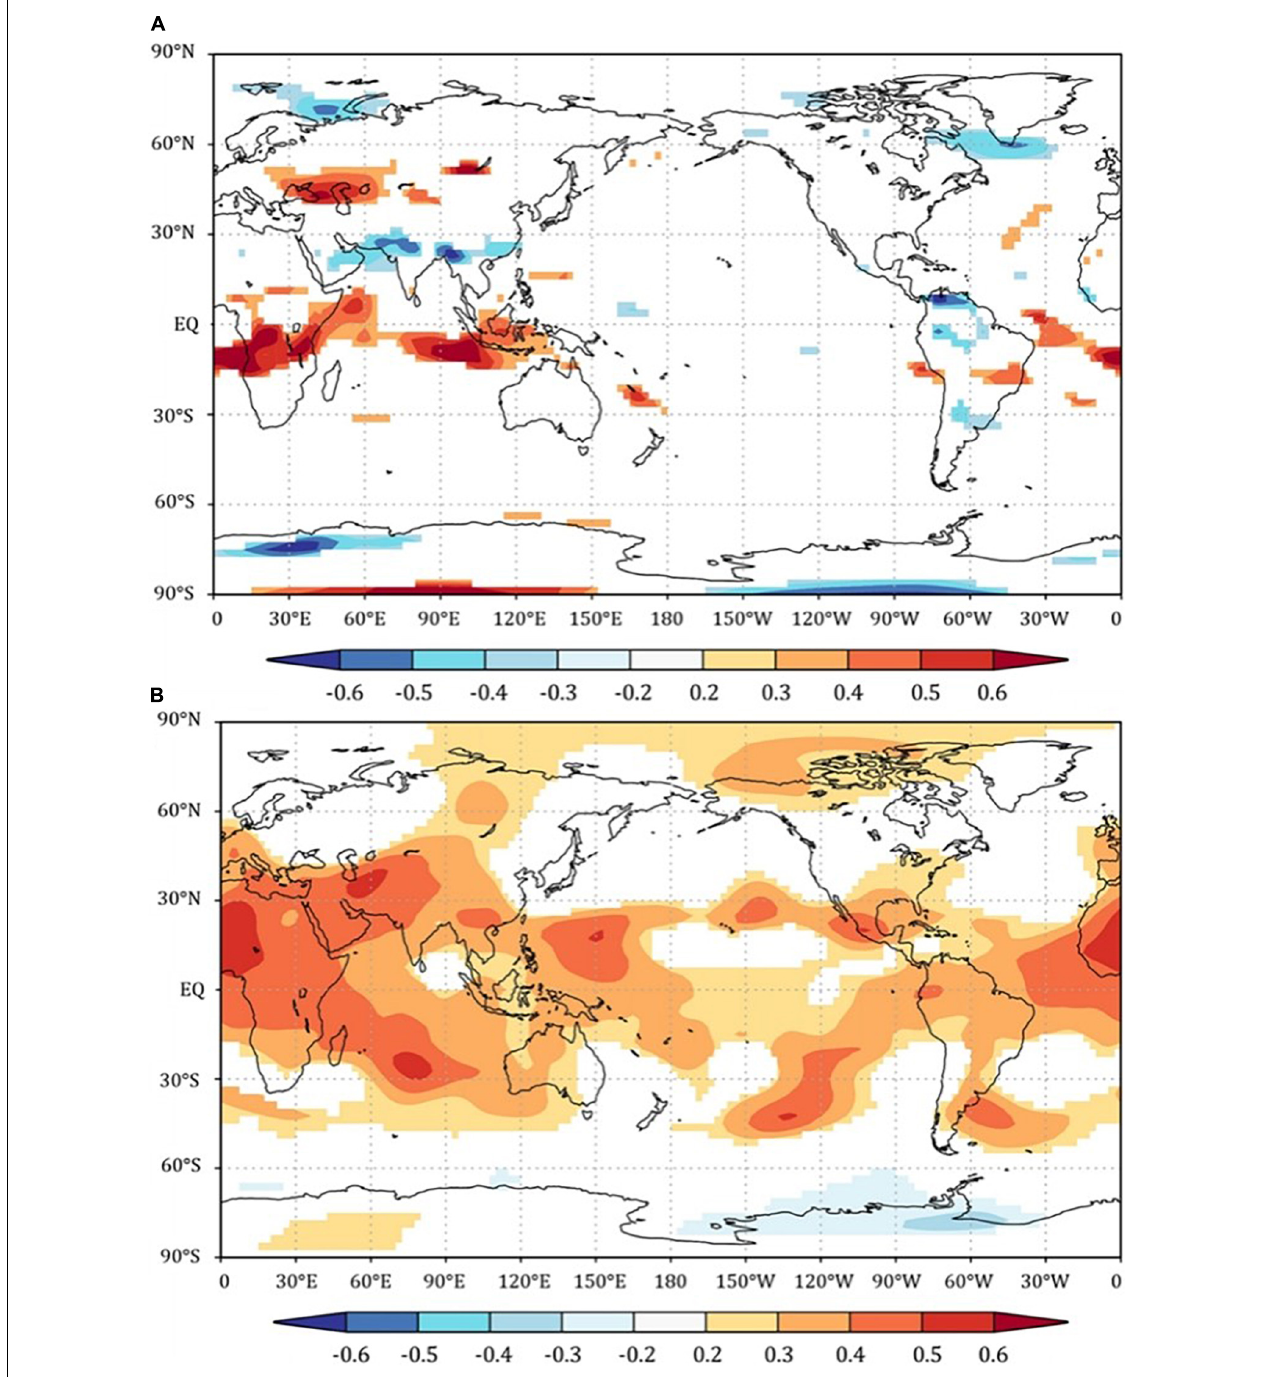
FIGURE 8 | Correlation coefficients between SCE 3 − 5 at the study site and (A) 700 hPa zonal wind and (B) 500 hPa geopotential height field. The shaded area passed the test at a 99% confidence